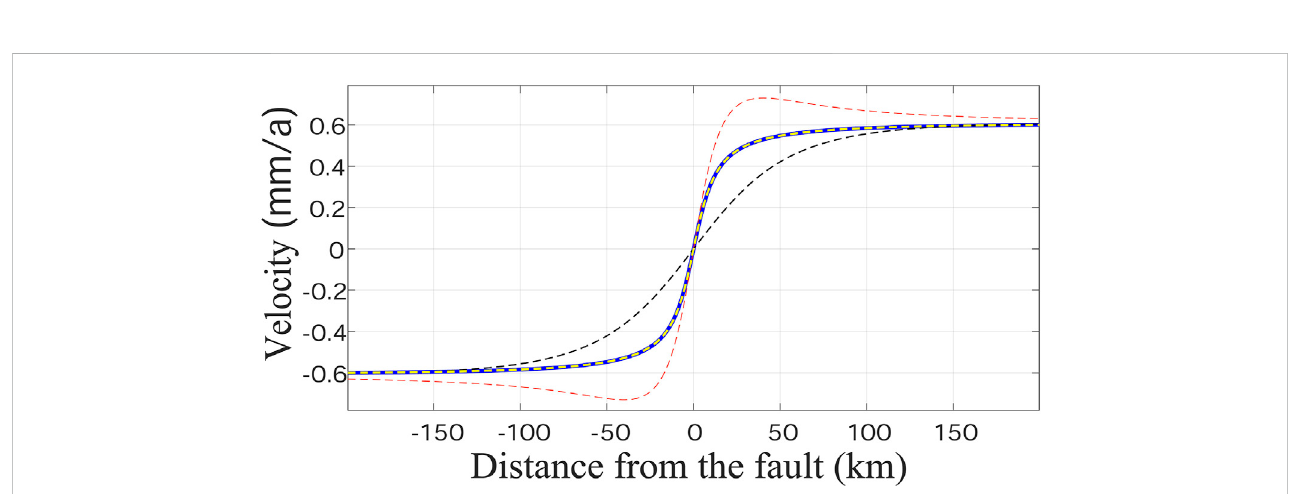
FIGURE 3 Curvesobtained fromthenumericalsimulationofC f ( d , L ) . θ valueis0.4, d is10 km, L is10,000 km(withoutconsidering theactualsituation,onlyforthe validation of the model), s is π mm/a, and the thick blue line is θ · s π ( tan − 1 x d − tan − 1 x d + L ) . Red and black dashed lines are the curves of C f ( d , L ) when n = 100. The curves are over- or underloaded because of the random positions of creeping segments in each patch; yellow dashed line ( n = 10,000) and blue line